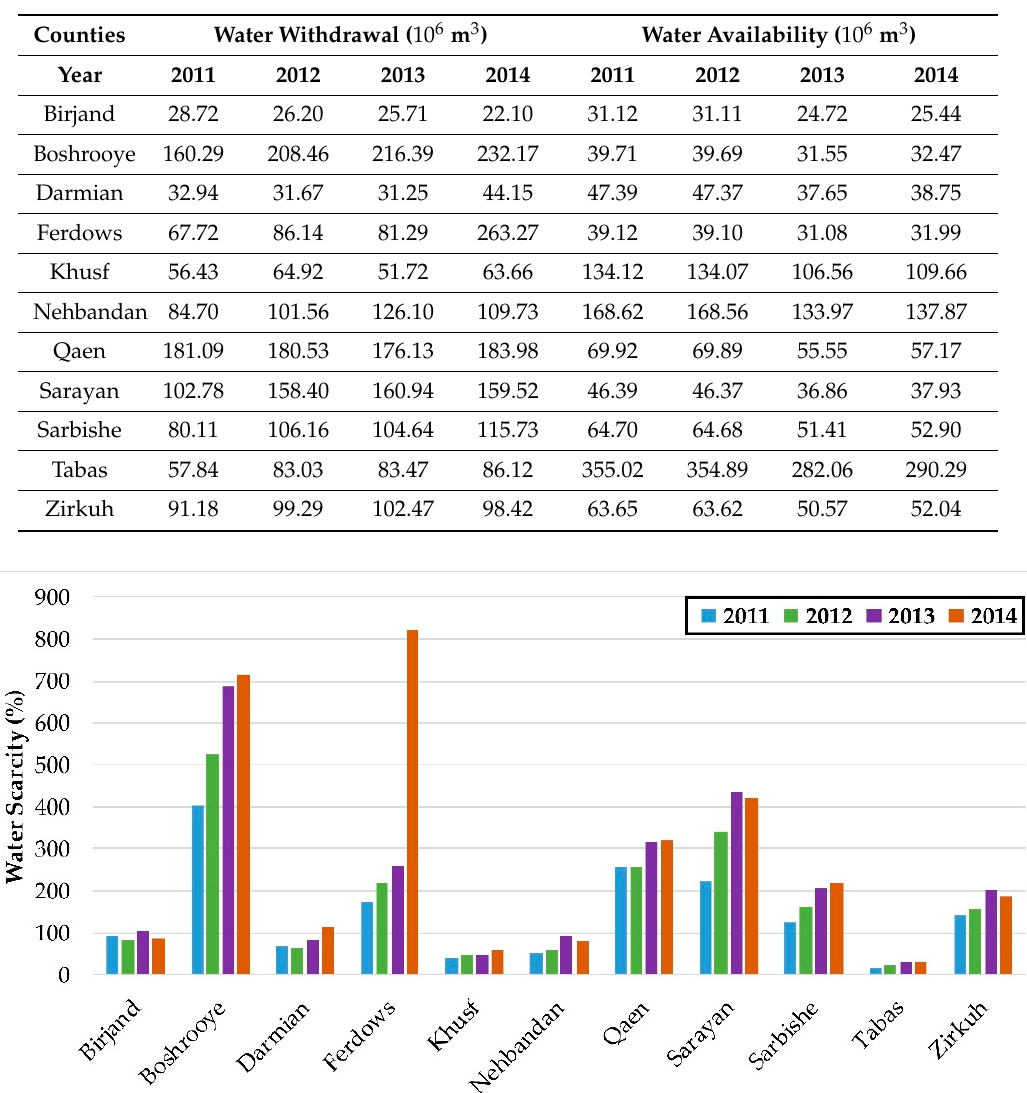
Table 5. Water withdrawals and availabilities for each county during 2011–2014.